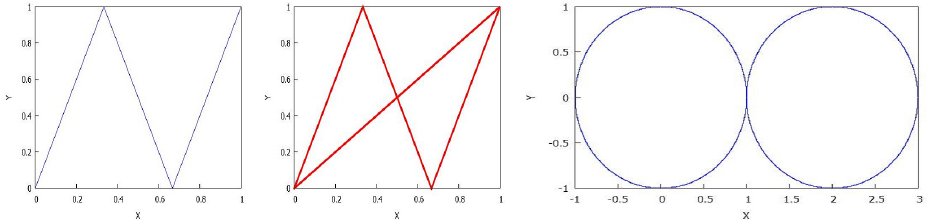
(( w )) homeomorphic to C 0 , w 0 4